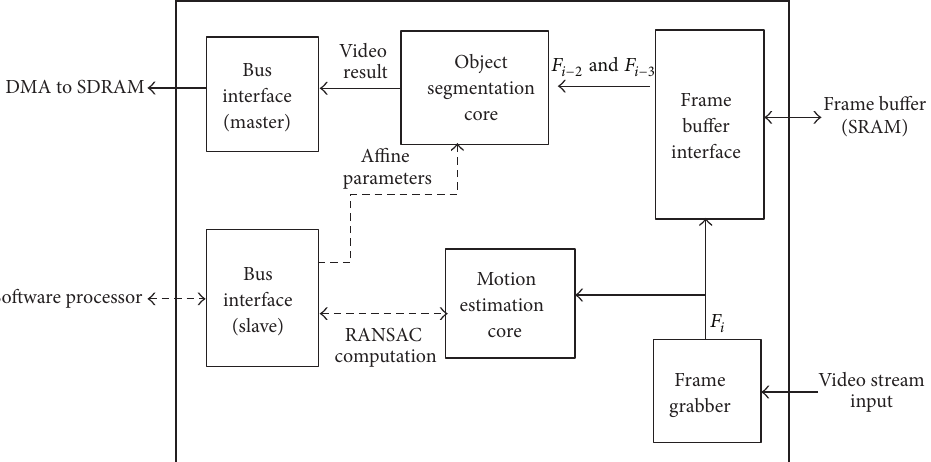
Figure 4: Hardware architecture of moving target